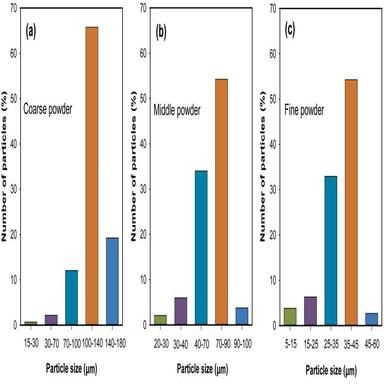
Size interval distributions of titanium particles: (a) Coarse powder; (b) Middle powder; (c) Fine powder.